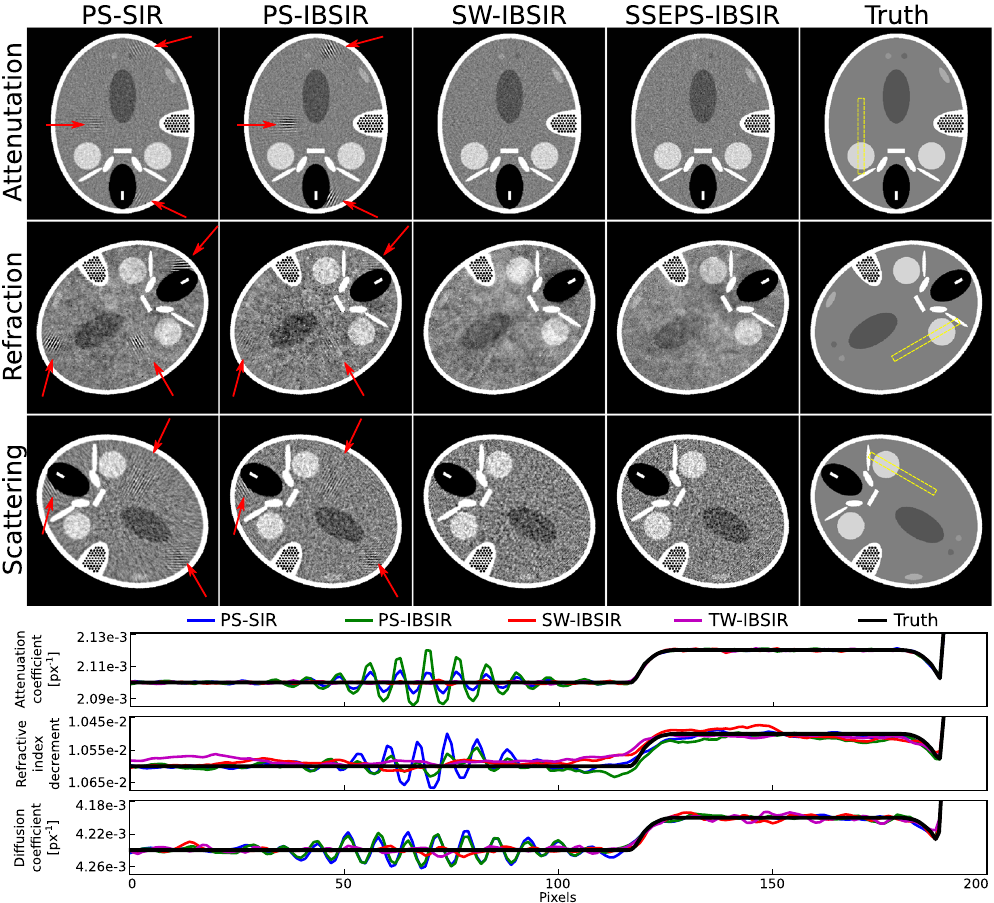
Figure 1. Comparison of different reconstruction methods for several acquisition patterns. The rows from top to bottom show reconstructions of a phantom’s attenuation, refractive index decrement and linear diffusion coefficient. (PS-SIR) shows reconstructions of a phase-stepping scan composed of 101 angular positions with 3 phase-steps each. (PS-IBSIR) shows reconstructions of the same scan using a direct interferogram-based reconstruction algorithm. Both reconstructions show distinct artifacts, marked by the arrows, caused by angular undersampling. (SW-IBSIR) uses the IBSIR algorithm to reconstruct a sliding window acquisition pattern composed of 303 angular positions using only a single, but changing, grating position. (SSEPS-IBSIR) is the reconstruction of a single-shot electromagnetic phase-stepping acquisition pattern using a single fixed grating position for 303 angular positions. Both methods strongly reduce the undersampling artifacts. Below the images line plots along the yellow box for all channels are